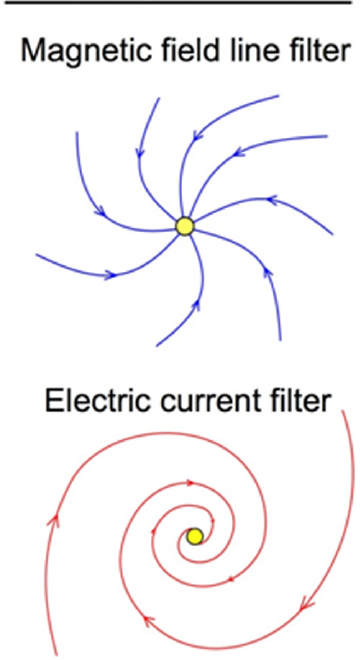
Fig. 26. The two views (magnetic field lines or electric currents) of the interplanetary system.